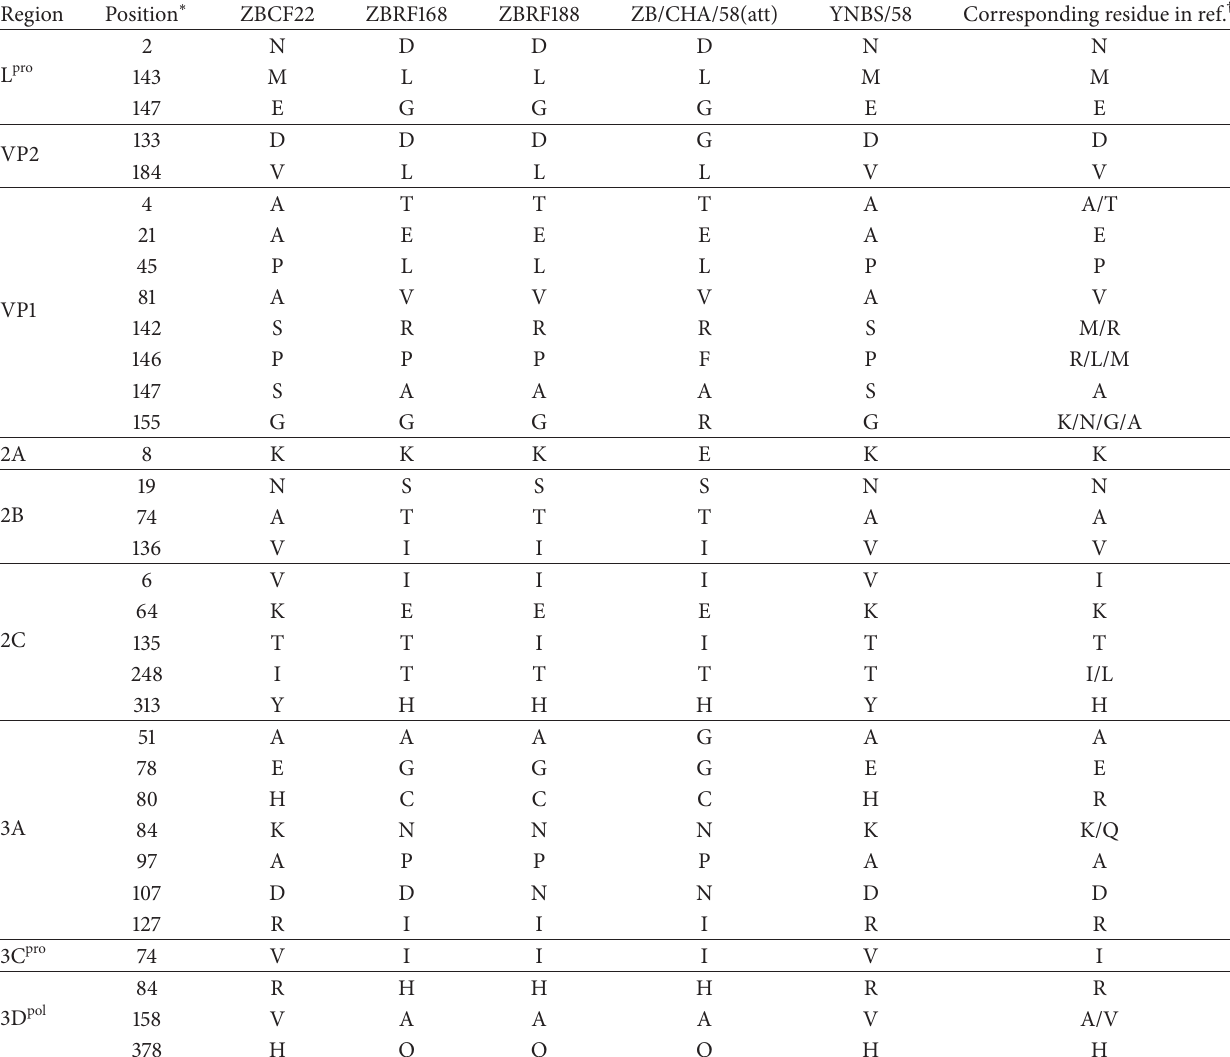
Table 3: Comparison of amino acid differences in the protein coding region between the virulent and attenuated ZB strains. Region Position ∗ ZBCF22 ZBRF168 ZBRF188 ZB/CHA/58(att) YNBS/58 Corresponding residue in ref.